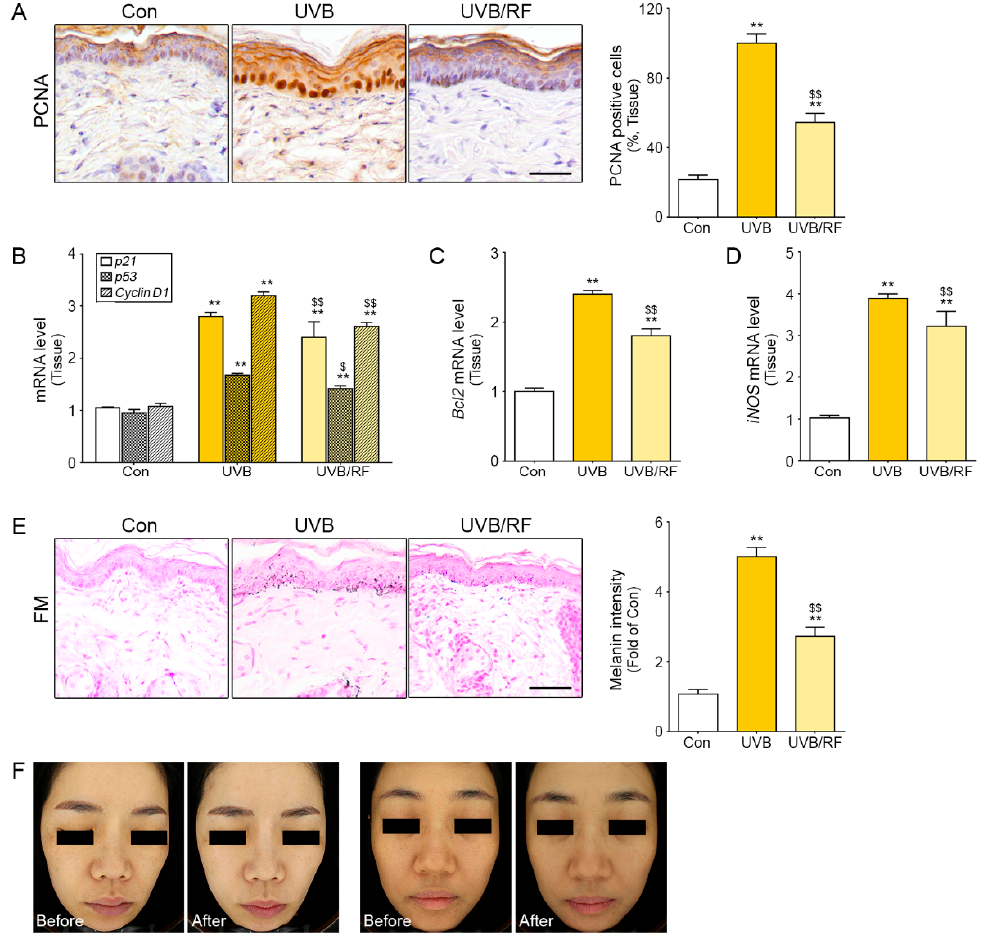
Figure 4. RF irradiation-induced macrophage activation, which had inhibitory effects on keratinocyte proliferation and pigmentation. ( A ) Keratinocyte proliferation in the epidermis of mouse skin was confirmed by detecting a proliferating cell marker (PCNA). The number of PCNA-positive cells was calculated from representative images. Scale bar = 100 µ m. Magnification, × 40. ( B – D ) The graphs show mRNA levels of cell cycle-related genes (p21, p53, and cyclin D1), an apoptosis regulator gene (Bcl2), and pro-inflammatory factors in the skin dermis of a UVB-radiated mouse. ( E ) The melanin amount was confirmed in the epidermis by Fontana Masson staining and by quantifying the melanin amounts from representative images. Scale bar = 100 µ m. Magnification, × 40. ( F ) In case 1, on the left, post-laser toning induced the development of post-inflammatory hyperpigmentation (PIH); melasma with background hyperpigmentation can be seen on the face. After RF irradiation, PIH disappeared, although melasma remained. In case 2, on the right, chronic dermatitis with hyperpigmentation in the forehead, periorbital, perioral, and neck areas was seen before RF irradiation. After RF irradiation, the hyperpigmentation decreased. ** p < 0.01 vs. Con group; $ p < 0.05 and $$ p < 0.01 vs. UVB group. Results are presented as means ± standard deviations. Con, sham control; mRNA, messenger RNA; PCNA, proliferating cell nuclear antigen; PIH, post-inflammatory hyperpigmentation; RF, radiofrequency; UVB, ultraviolet